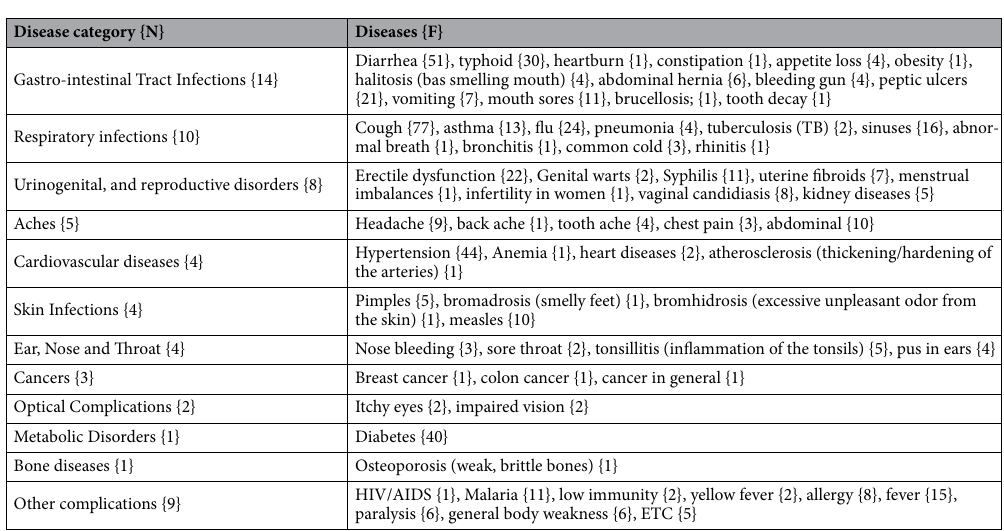
Disease category